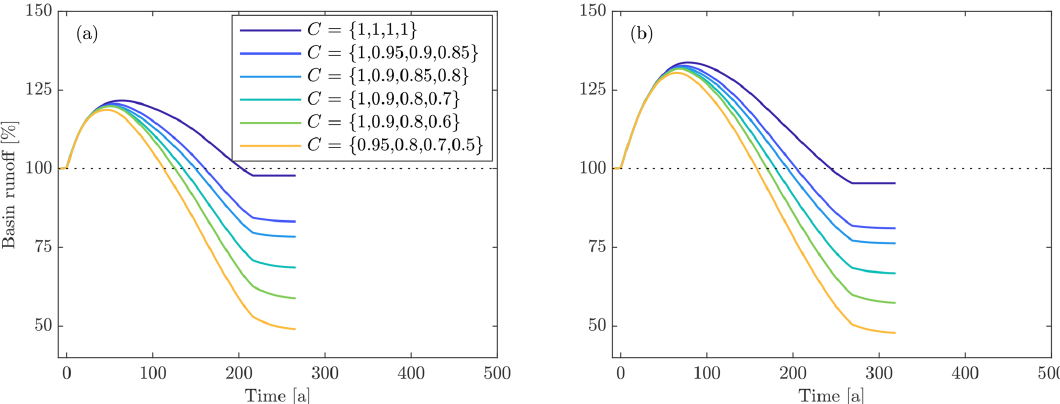
Figure 4. Variations in basin runoff for differing types of catchment vegetation as expressed by runoff ratios in (a) maritime and (b) con- tinental climates. The basin slope (5 ◦ ), climate change scenario (RCP8.5), and vegetation timing ( T = { 15 , 30 , 50 } ) are the same in both